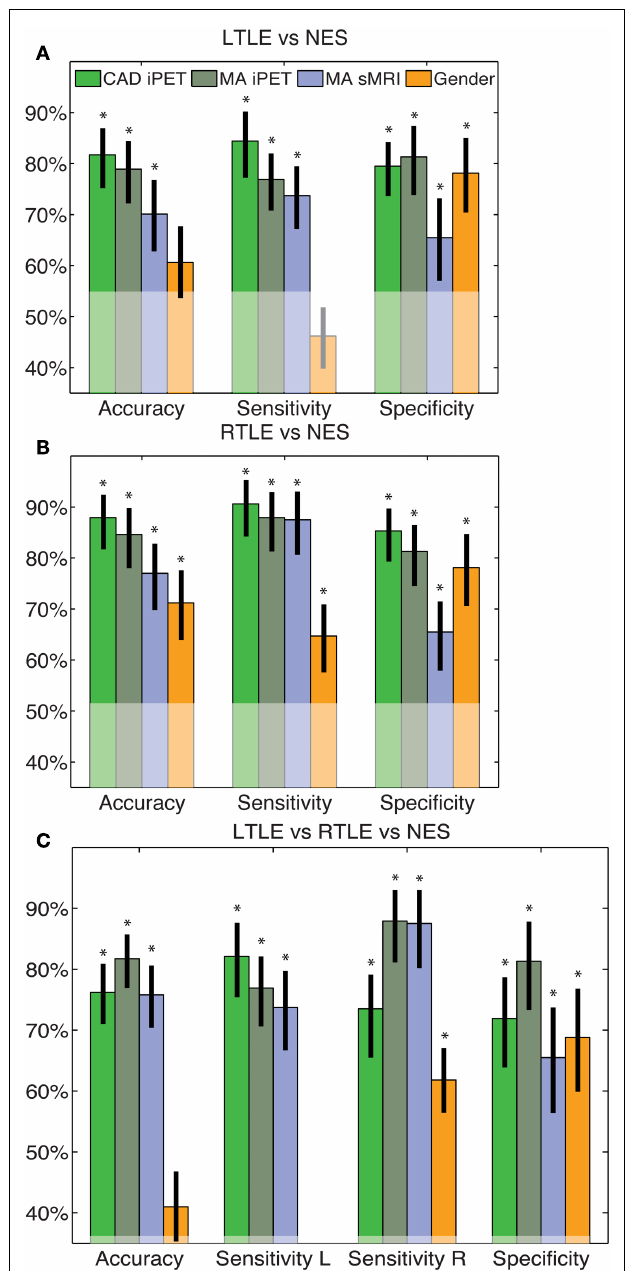
FIGURE 1 | CAD tool performance matches manual analysis. These figures indicate the accuracy, sensitivity and specificity of the LTLE (A) , RTLE (B) and trinary (C) classifiers.The performance of our CAD tools matched that of MA and was superior to just using gender alone.The error bars indicate standard error of the mean performance for each measure. The translucent region indicates the performance of a naïve classifier. *Indicates significant differences from the naïve classifier with a confidence level of 95% or more.